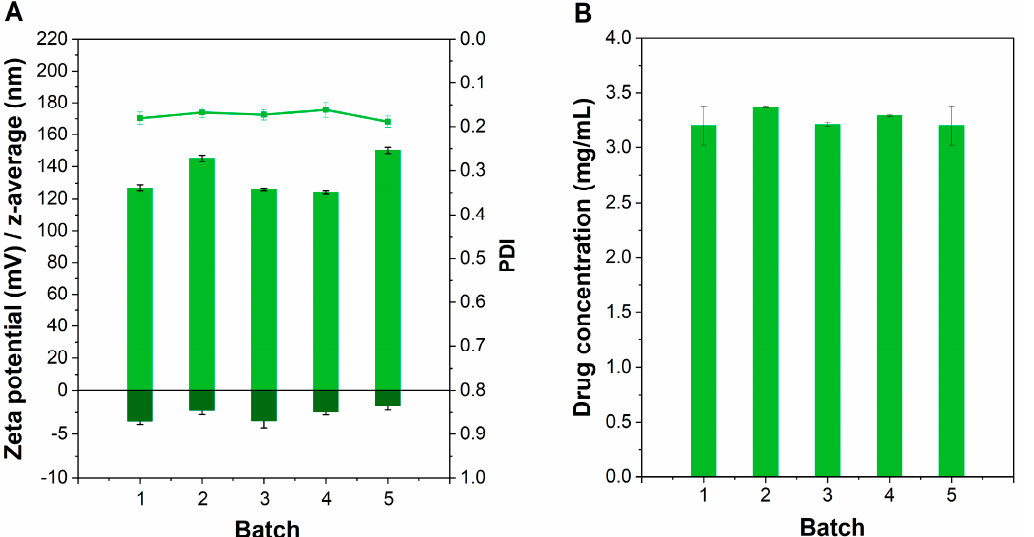
Figure 2. Batch reproducibility of HPMC gel manufacture with ( A ) indicating the reproducibility of five batches regarding their physicochemical characteristics including particle size (left axis, light green bars), zeta potential (left axis, dark green bars), and PDI (green line) and ( B ) presenting the drug content of different batches (light green bars) after freeze-drying (Mean ± SD, n = 5). The residual water content of 0.70% ± 0.02% of these lyophilizates was determined